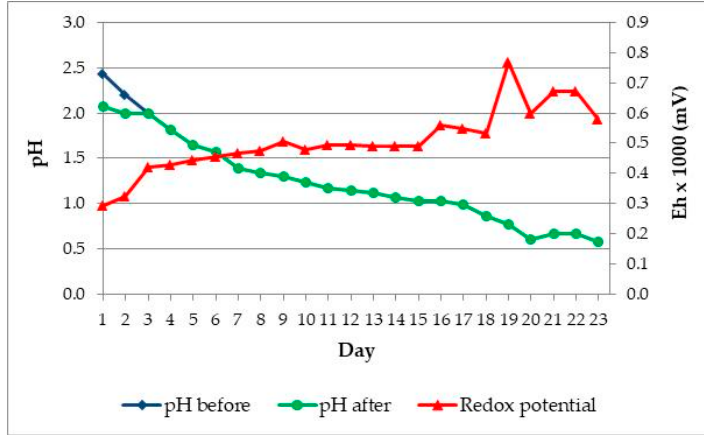
Figure 4. The changes pH and Eh (mV) vs. time in Adaptation III. Black circles—pH before H 2 SO 4 addition; blue squares—pH after H 2 SO 4 addition; red triangles - Eh (mV).